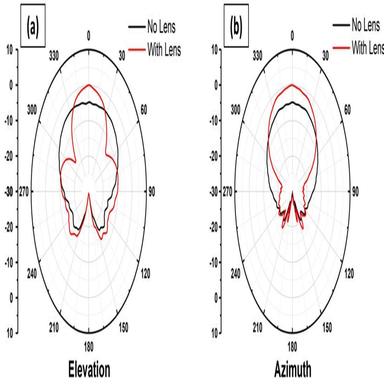
Measured radiation patterns in (a) Elevation and (b) Azimuth planes of the hemispherical dielectric lens above the patch antenna.